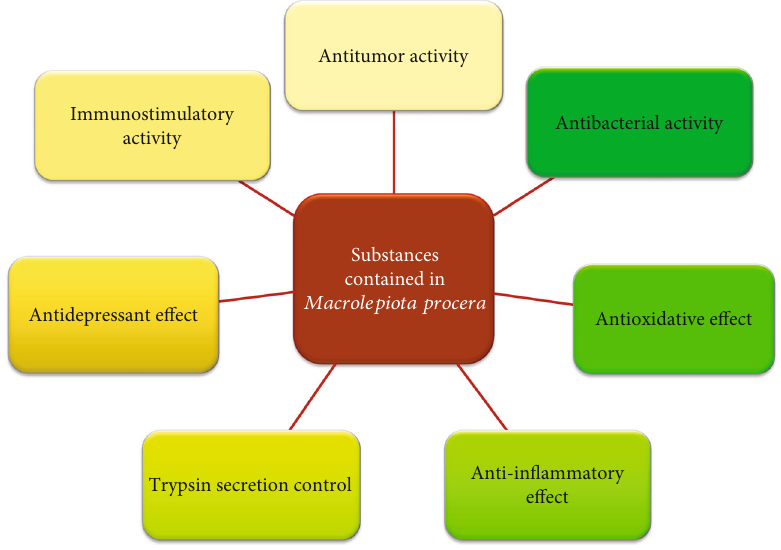
Figure 5: Bioactive e ff ect of Macrolepiota